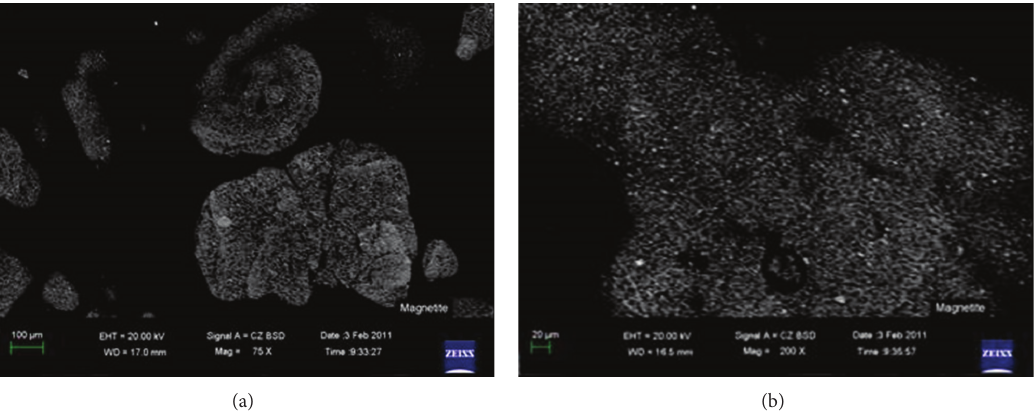
Figure 4: Back Scatter Electron (BSE) images of pure magnetite at different magnifications (a) (75X) and (b) (200X), (a) morphology of particles before milling and (b) morphology of particle after milling for 20 hrs.